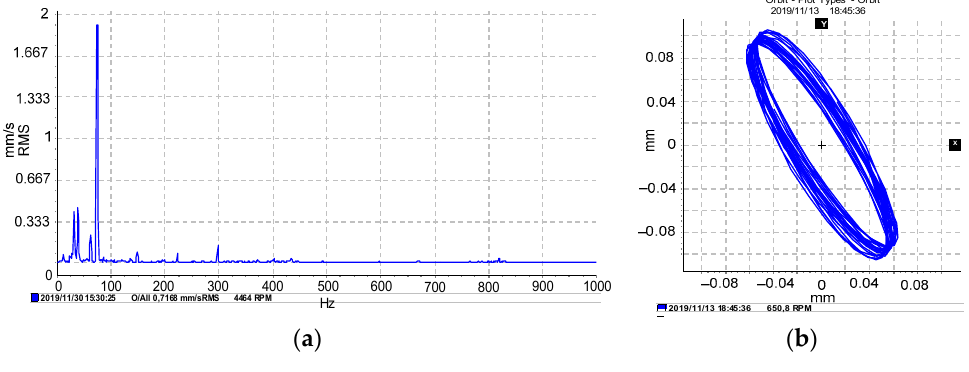
Figure 6. Rotor unbalance: ( a ) Frequency response; ( b ) rotor orbit.